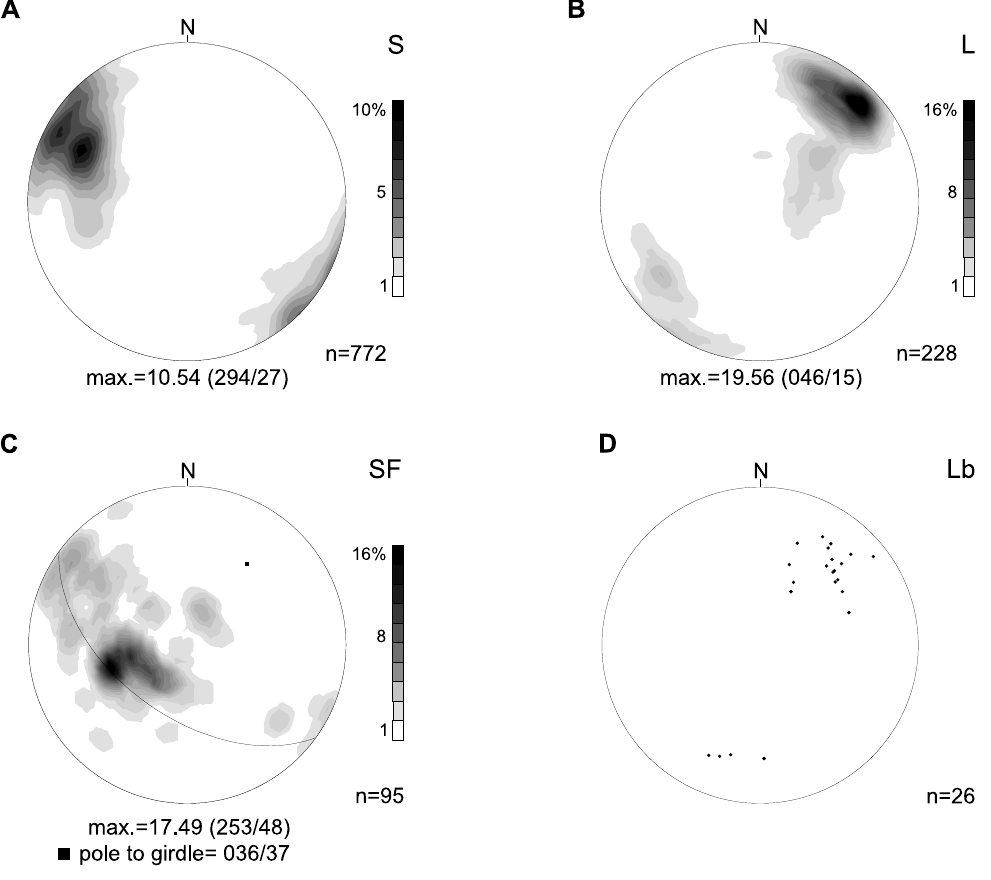
Fig. 6 – Global structural data. A – Poles to foliation (S), B – Mineral and stretching lineation (L), C – Poles to fold planes (SF) with statistically-